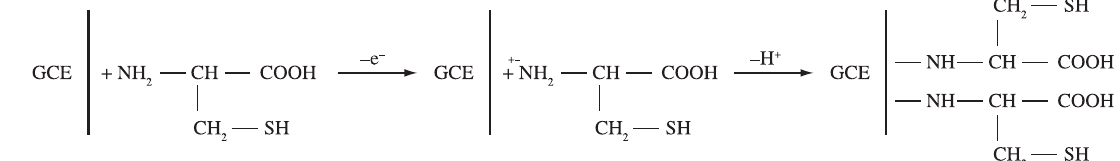
Scheme 2. Mechanism of oxidation of L-cysteine by one-electron from amino